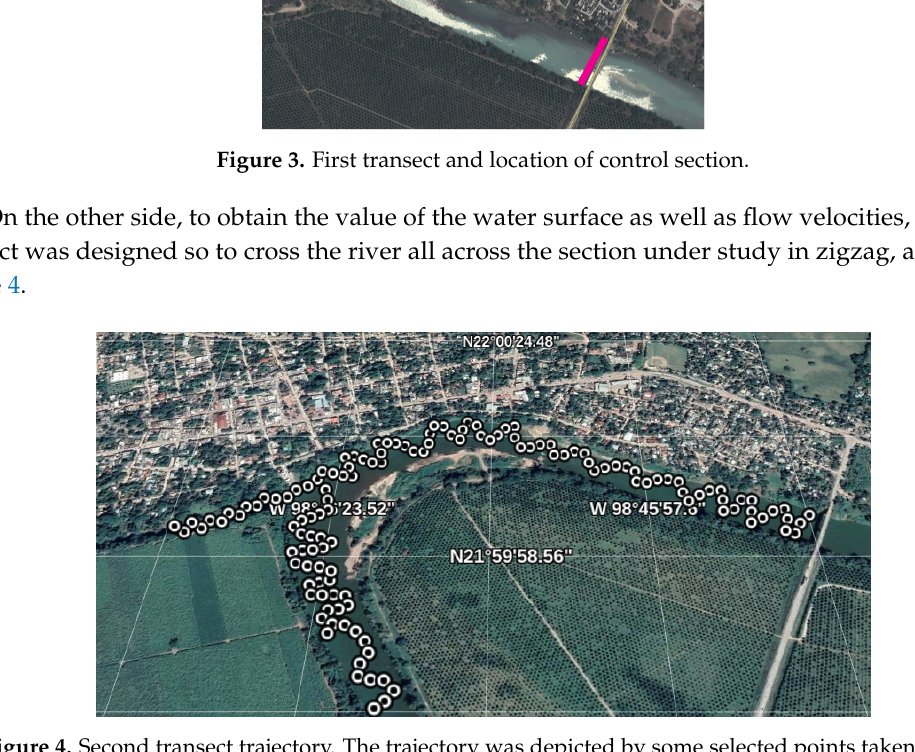
Figure 4. Second transect trajectory. The trajectory was depicted by some selected points taken by the ADCP system to ease its